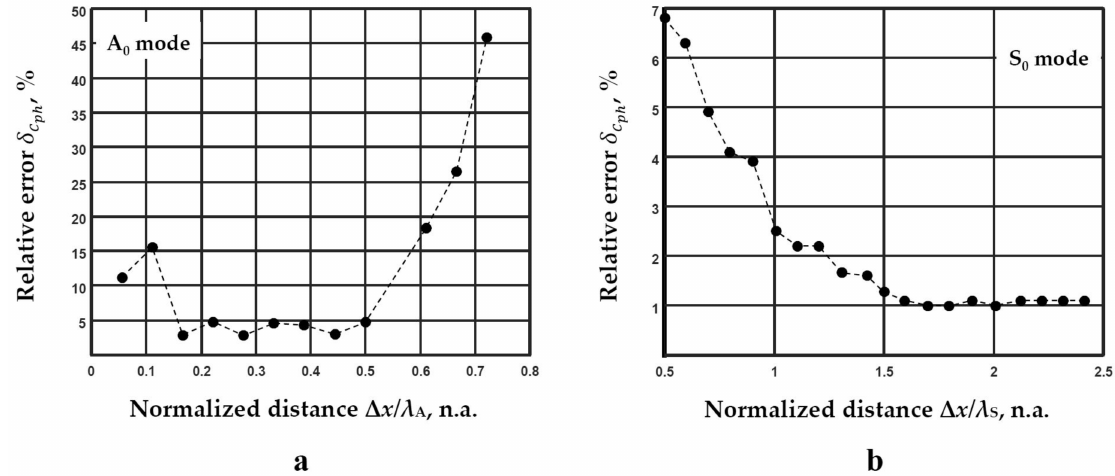
Figure 9. The deviation of the obtained phase velocities from the values calculated by the 2D-FFT method for the A 0 mode ( a ) and S 0 modes ( b